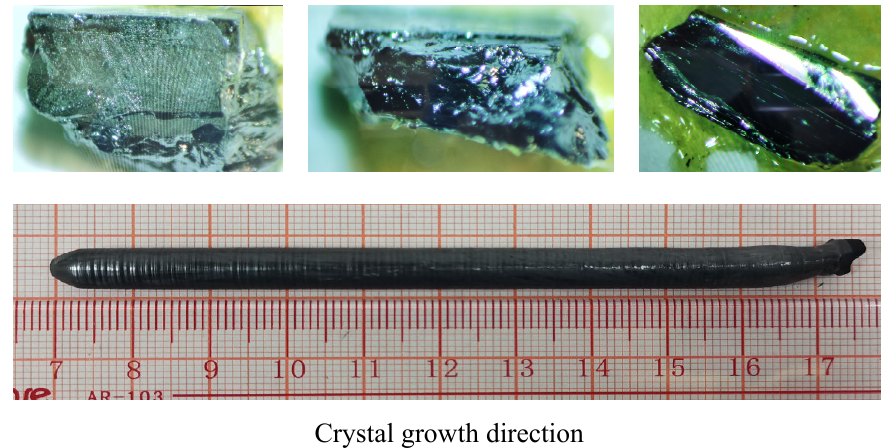
Figure 2. (color online) (top row) Some cleaved pieces of the grown crystal display the natural crystallographic ab plane and shining surfaces. (bottom row) One representative image of a La 1.37 Sr 1.63 Mn 2 O 7 crystal as grown by our laser-diode-heated floating-zone furnace with a mixture of working gases ( ∼ 90% Ar + ∼ 10% O 2 ) under a pressure of ∼ 0.5 MPa. The bottom arrow points out the crystal growth direction.